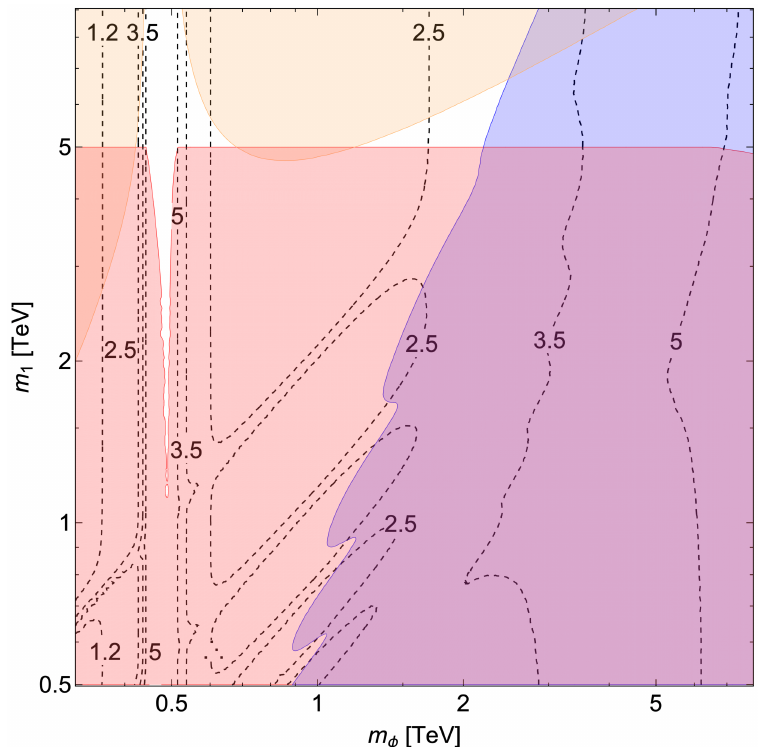
Figure 10 . Experimental and theoretical limits on thermally produced real scalar DM in the RS model. The values of Λ [TeV] needed for m r = 1 TeV to obtain Ω h 2 = 0 . 12 through freeze-out are DM indicated by the labels on the dashed contours. The red regions is excluded by LHC searches for di-photon resonances. The blue (orange) region is outside of the range of validity of perturbative computations due to breakdown of partial wave unitarity (large graviton width, Γ 1 ≥ m 1 / 2 ). In the white region thermal production of the observed relic density is